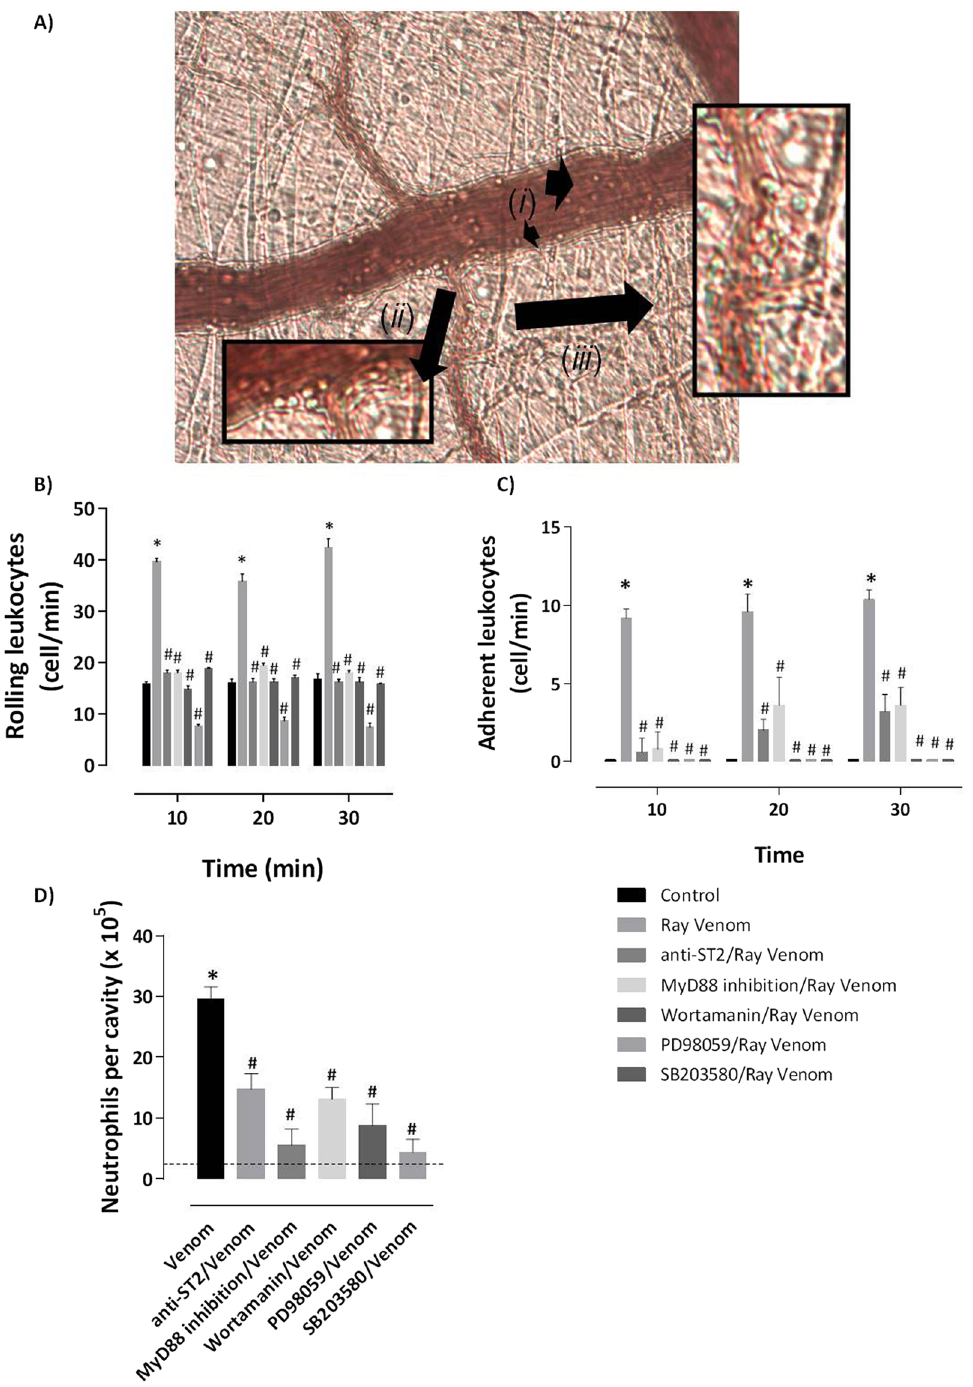
Figure 3. Signals derived from ST2 receptor mobilize leukocytes in post-capillary venules. Swiss mice ( n = 4–7 per group) were previously treated for 30 min with intraescrotal injection of 5 μ g neutralizing anti-ST2 antibody, that, animals were anesthetized and the cremaster muscle were exposed to topical application of 300 μ g/ml of stingray venom or sterile saline in 30 µ l. Mobilization of leukocytes in post-capillary venules ( A ) was observed for 30 min, and the number of rolling ( B ) and adherent ( C ) leukocytes were counted. The number of neutrophils ( D ) was counted in exudates of peritoneal cavities collected at 2 h from pretreated mice injected with ray venom. Results represent mean ± SEM. Results of two independent experiments are shown. * p < 0.05 compared with the control-group (dotted line) and # p < 0.05 compared to untreated mice that received topically applied ray